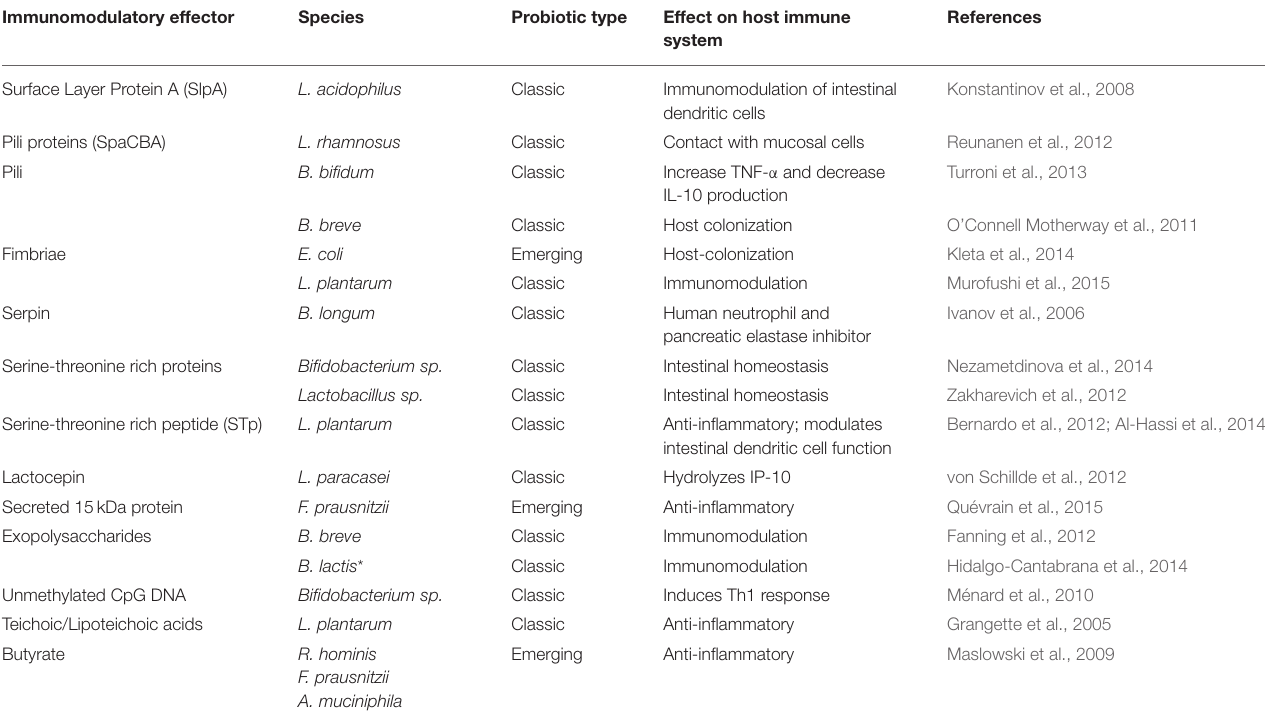
TABLE 1 | Examples of immunomodulatory effectors produced by classic/emerging